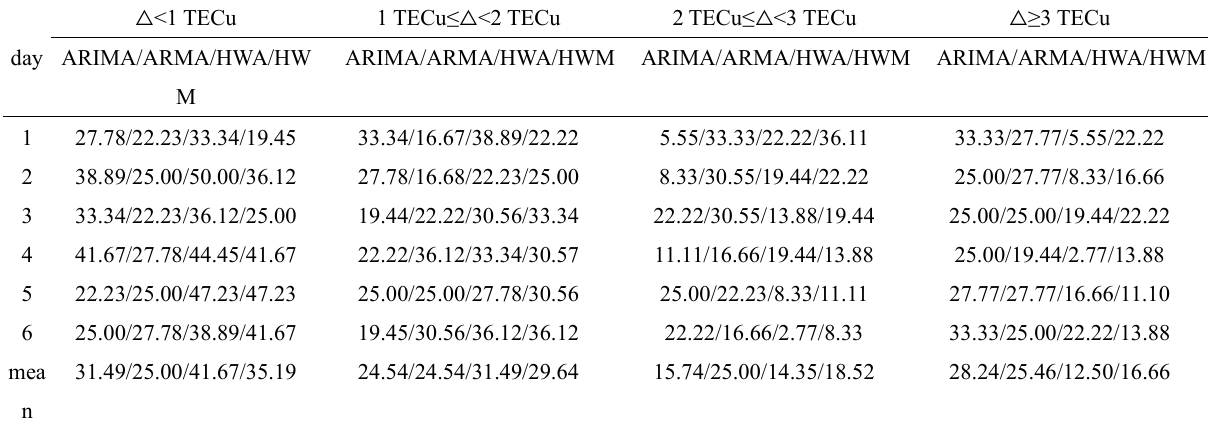
Table 1. Category percentage table of prediction residuals in ionospheric quiet